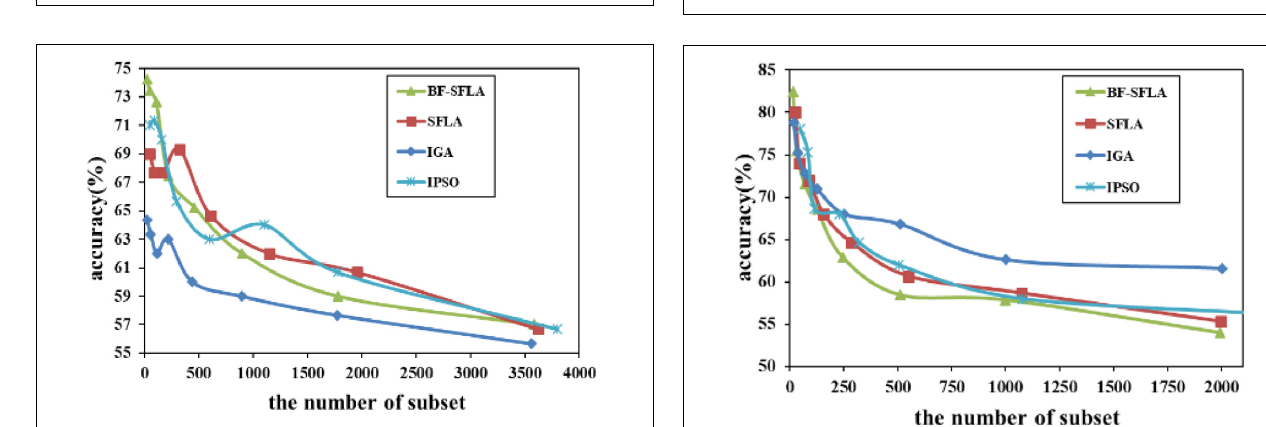
FIGURE 8 | The variation trend of classification accuracy and feature subset of LungCancer-Ontario.